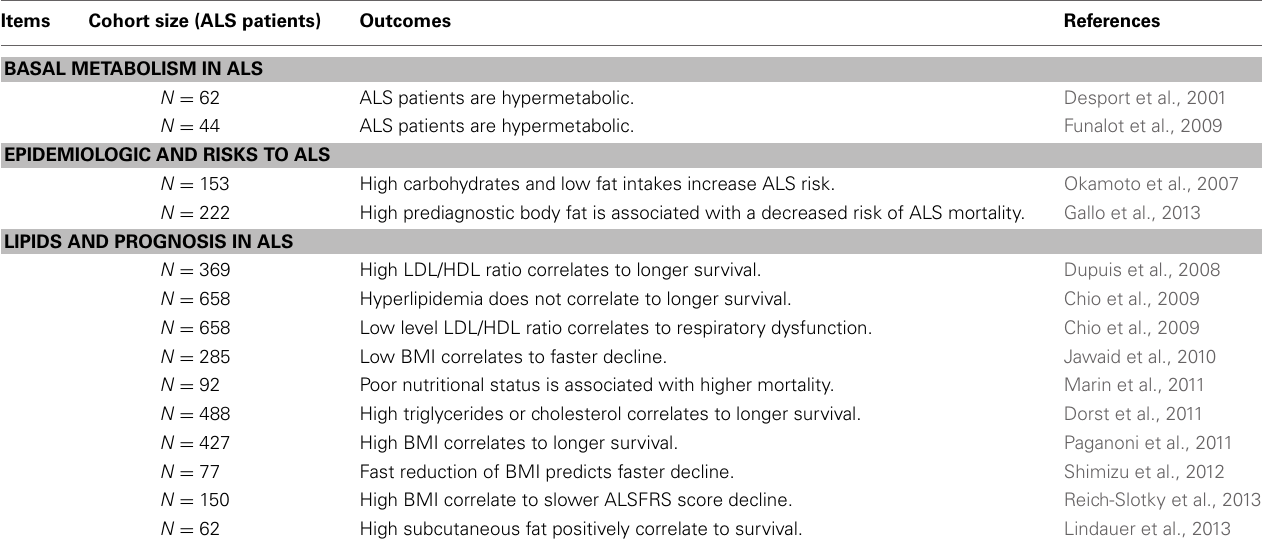
Table 1 | Altered energetic metabolism in ALS patients. Items